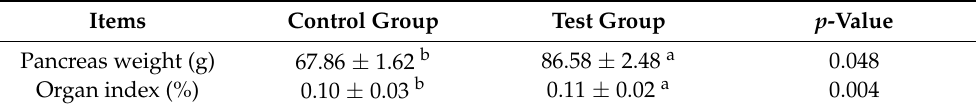
Table 5. Effect of concentrate supplementation on pancreatic organ index of yak calves.